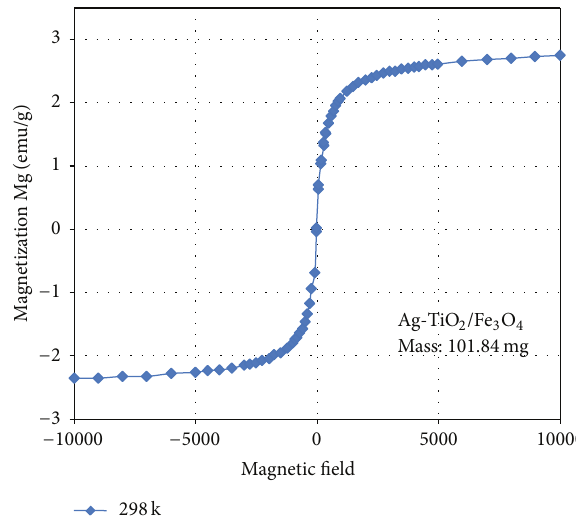
Figure 7: Magnetization curves of Ag-TiO 2 /Fe 3 O 4 at room temperature.